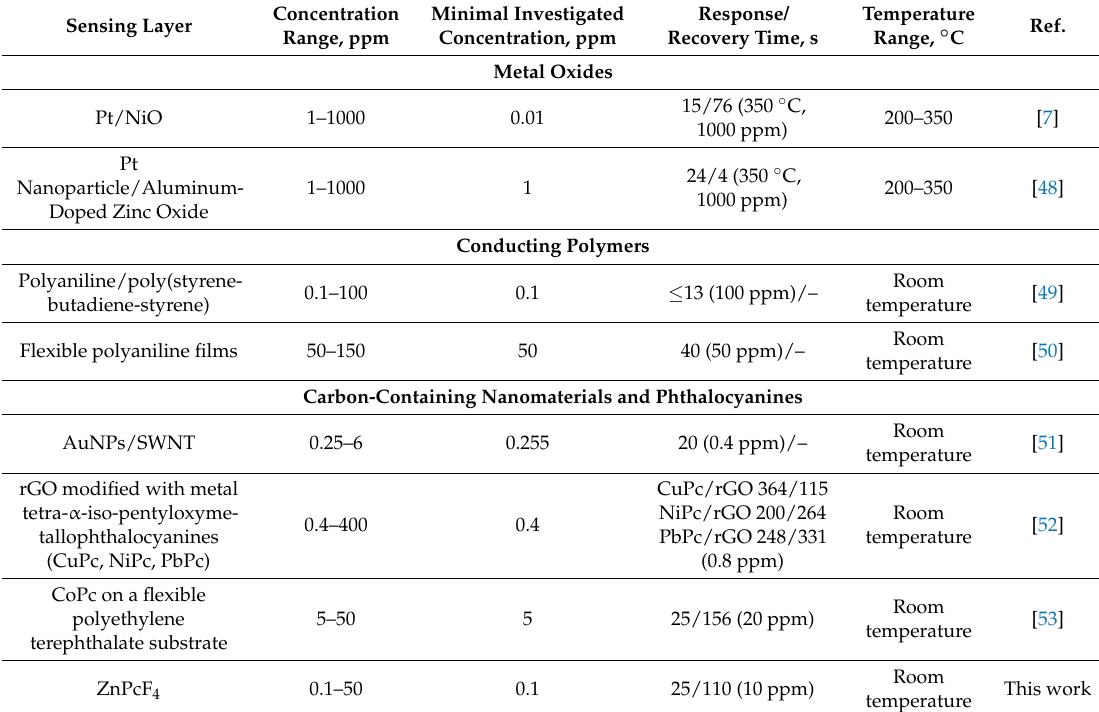
Table 3. Sensor performance of active layers based on metal oxides, conducting polymers, carbon- containing nanomaterials, and